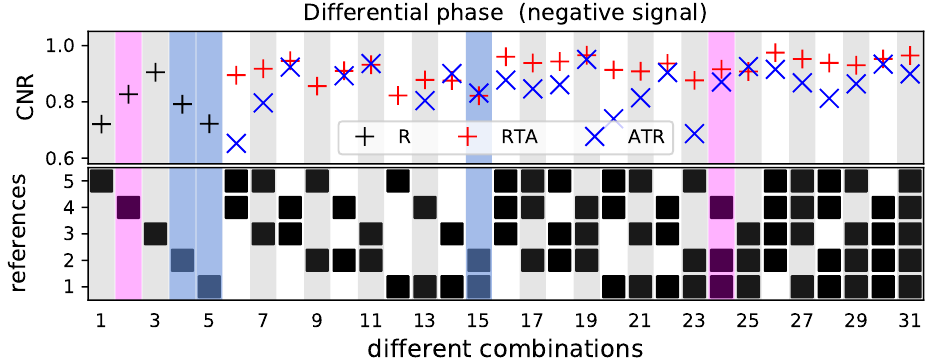
Figure 5. CNR for the ROI with the negative DPC signal, marked in Figure 2a. The STD and contrast values are given in radian. The plot in the last row indicates which reference images were used for deriving the values in the respective column. The black markers indicate the values if only one reference image is used. The red and blue markers show the results for the RTA and ATR method, respectively. For combinations 9 and 12, the ATR method results in images with high standard deviation and low contrast and CNR, which are not within the range of the axis. The values in the colored columns are used for a detailed